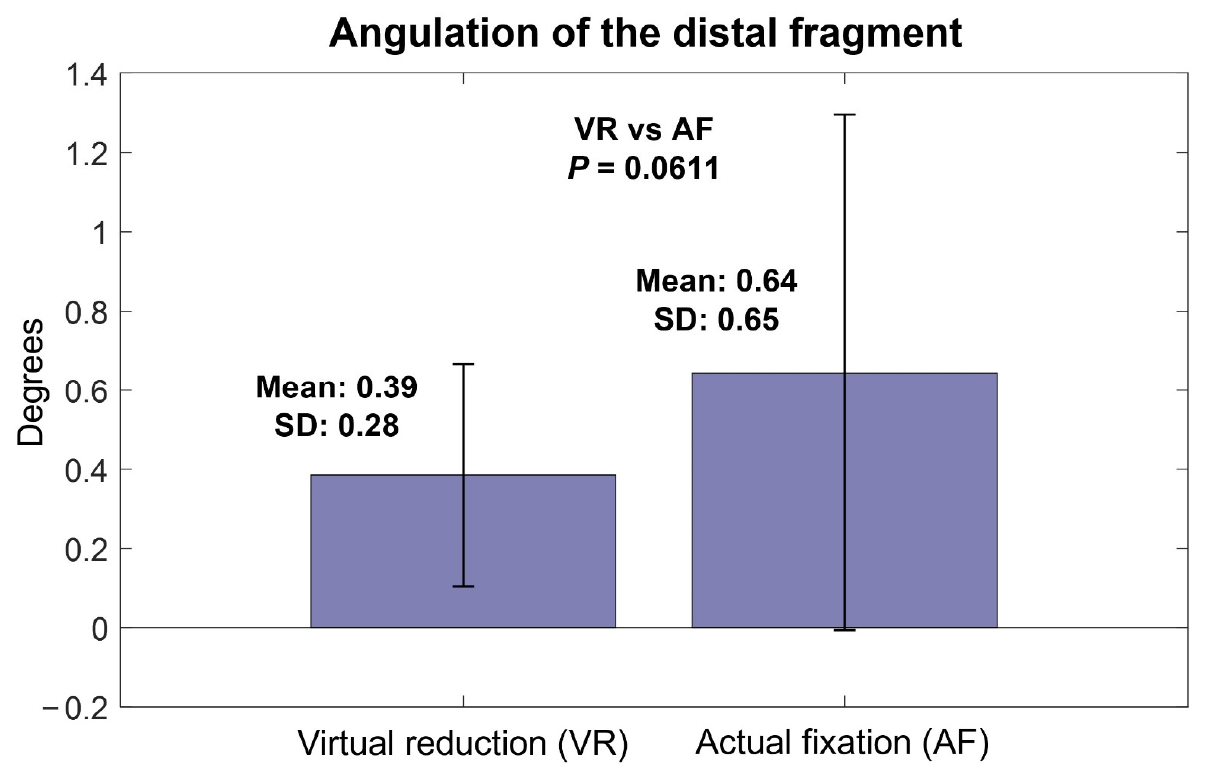
Figure 5. Angulation of virtual reduction and actual fixation models relative to intact models.